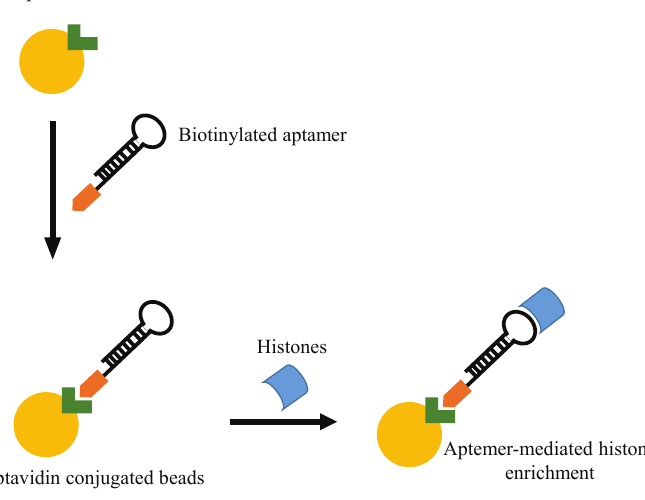
Figure 4. Aptamer-mediated histone enrichment. Scheme of the strategy used by Shao N et al. for histone enrichment by using aptamers.